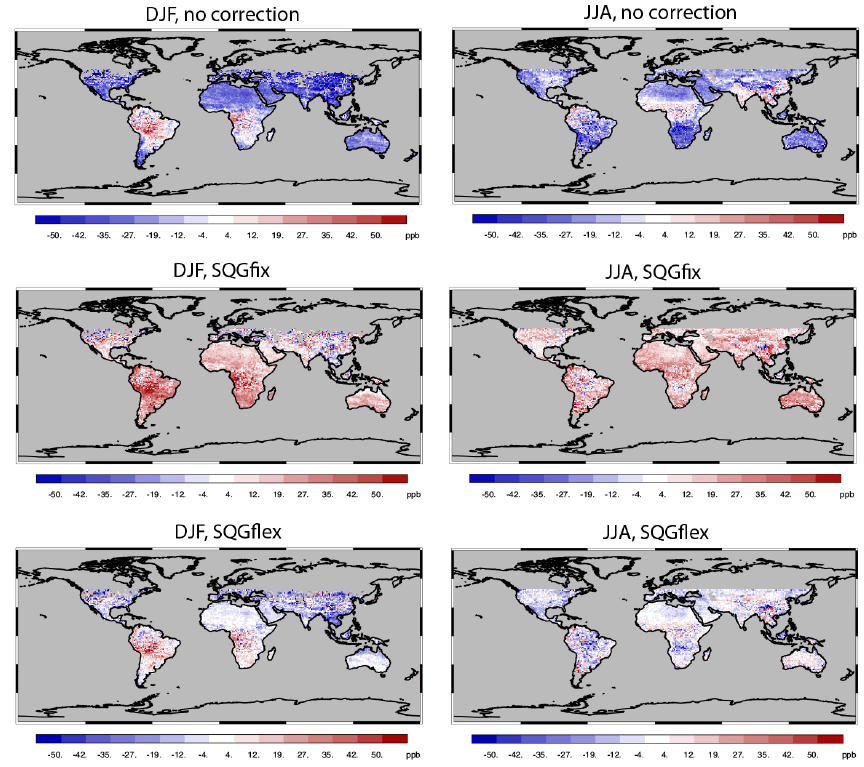
Fig. 5. The difference in X CH 4 between SCIAMACHY and NOAA-optimized TM5 (SCIAMACHY – TM5) with and without SCIAMACHY bias correction. Results represent seasonal averages for DJF (left) and JJA (right). Top: uncorrected SCIAMACHY, middle: SQG fix corrected SCIAMACHY, bottom: SQG flex corrected SCIAMACHY. For the corresponding bias coefficients see Table 2.